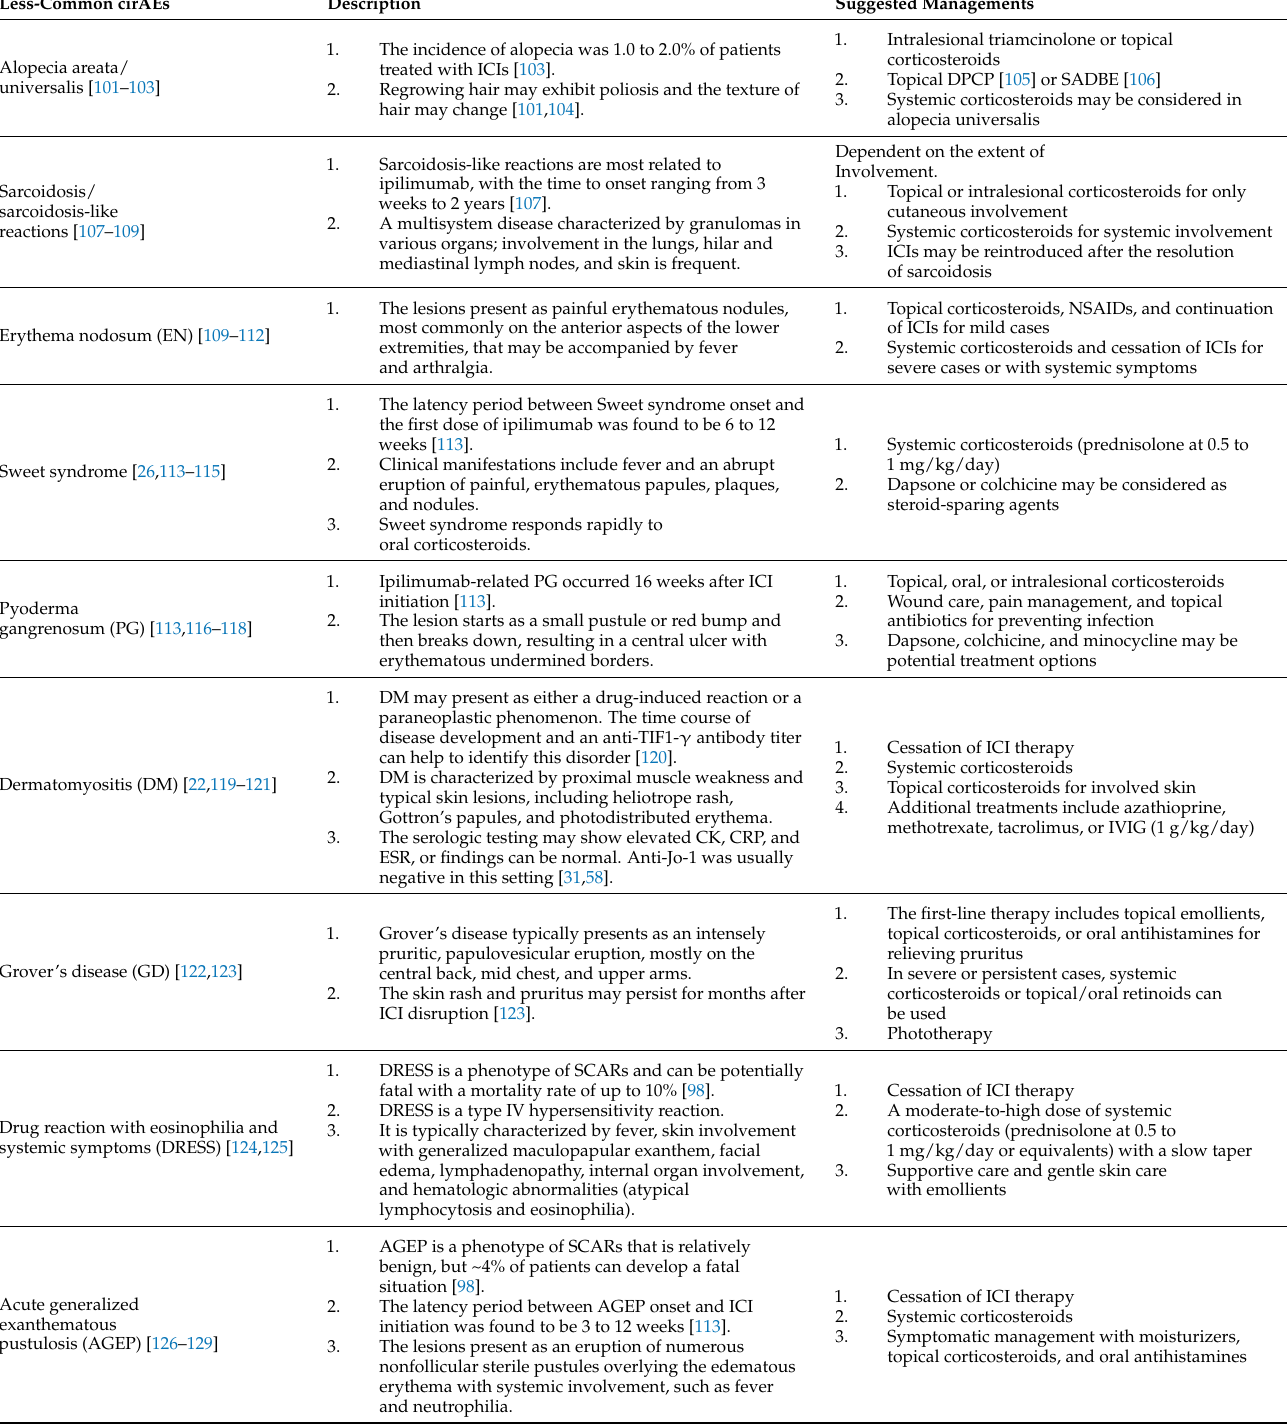
Table 3. Other less-common dermatologic toxicities associated with immune checkpoint